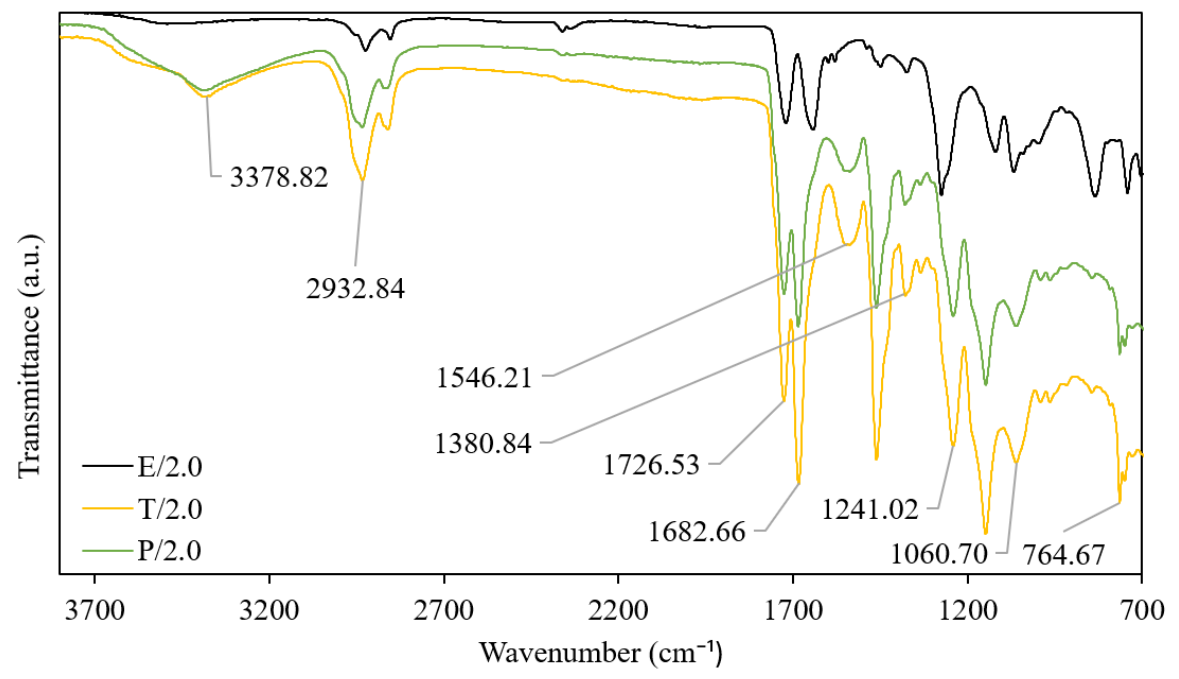
Figure 3. FTIR spectra of dual-layer PU coating with 1.0 wt.% of silica nanoparticle in different solvents (ethanol — E/1.0, THF — T/1.0, paint thinner — P/1.0).